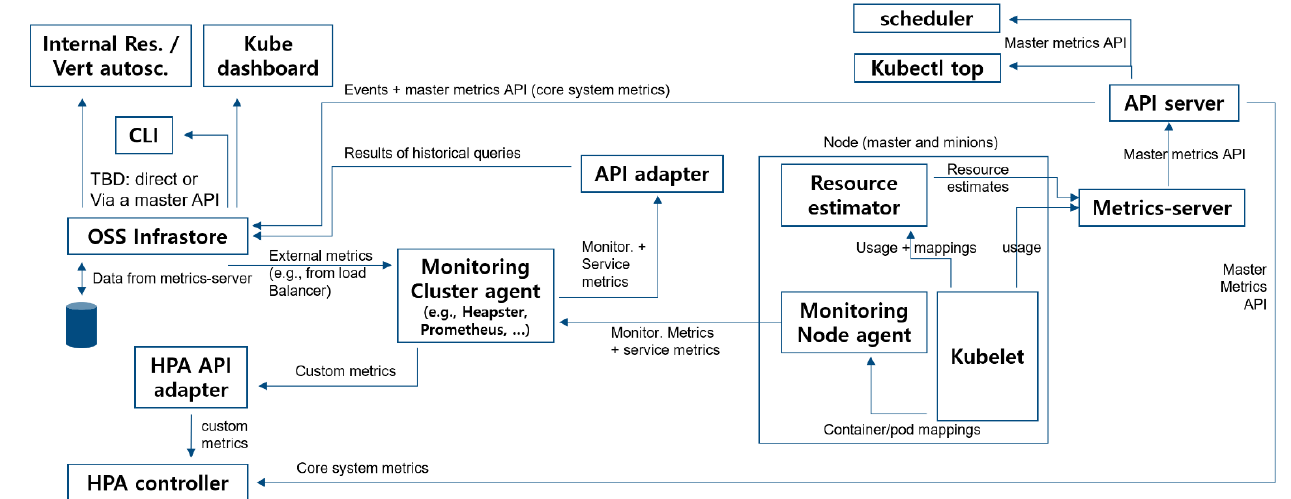
Figure 3. Customized Kubernetes Environmental Monitoring Architecture.